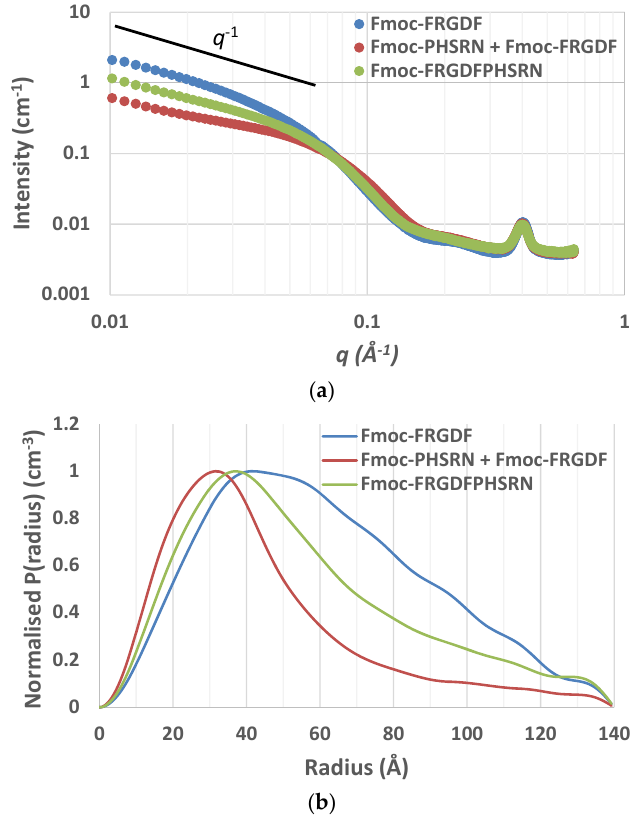
Figure 3. ( a ) SAXS scattering curve of SAPs Fmoc-FRGDF and Fmoc-FRGDF/Fmoc-PHSRN displaying q − 1 relationship at low q angles. ( b ) P(r) inversion plot of SAPs Fmoc-FRGDF and Fmoc-FRGDF/Fmoc-PHSRN.